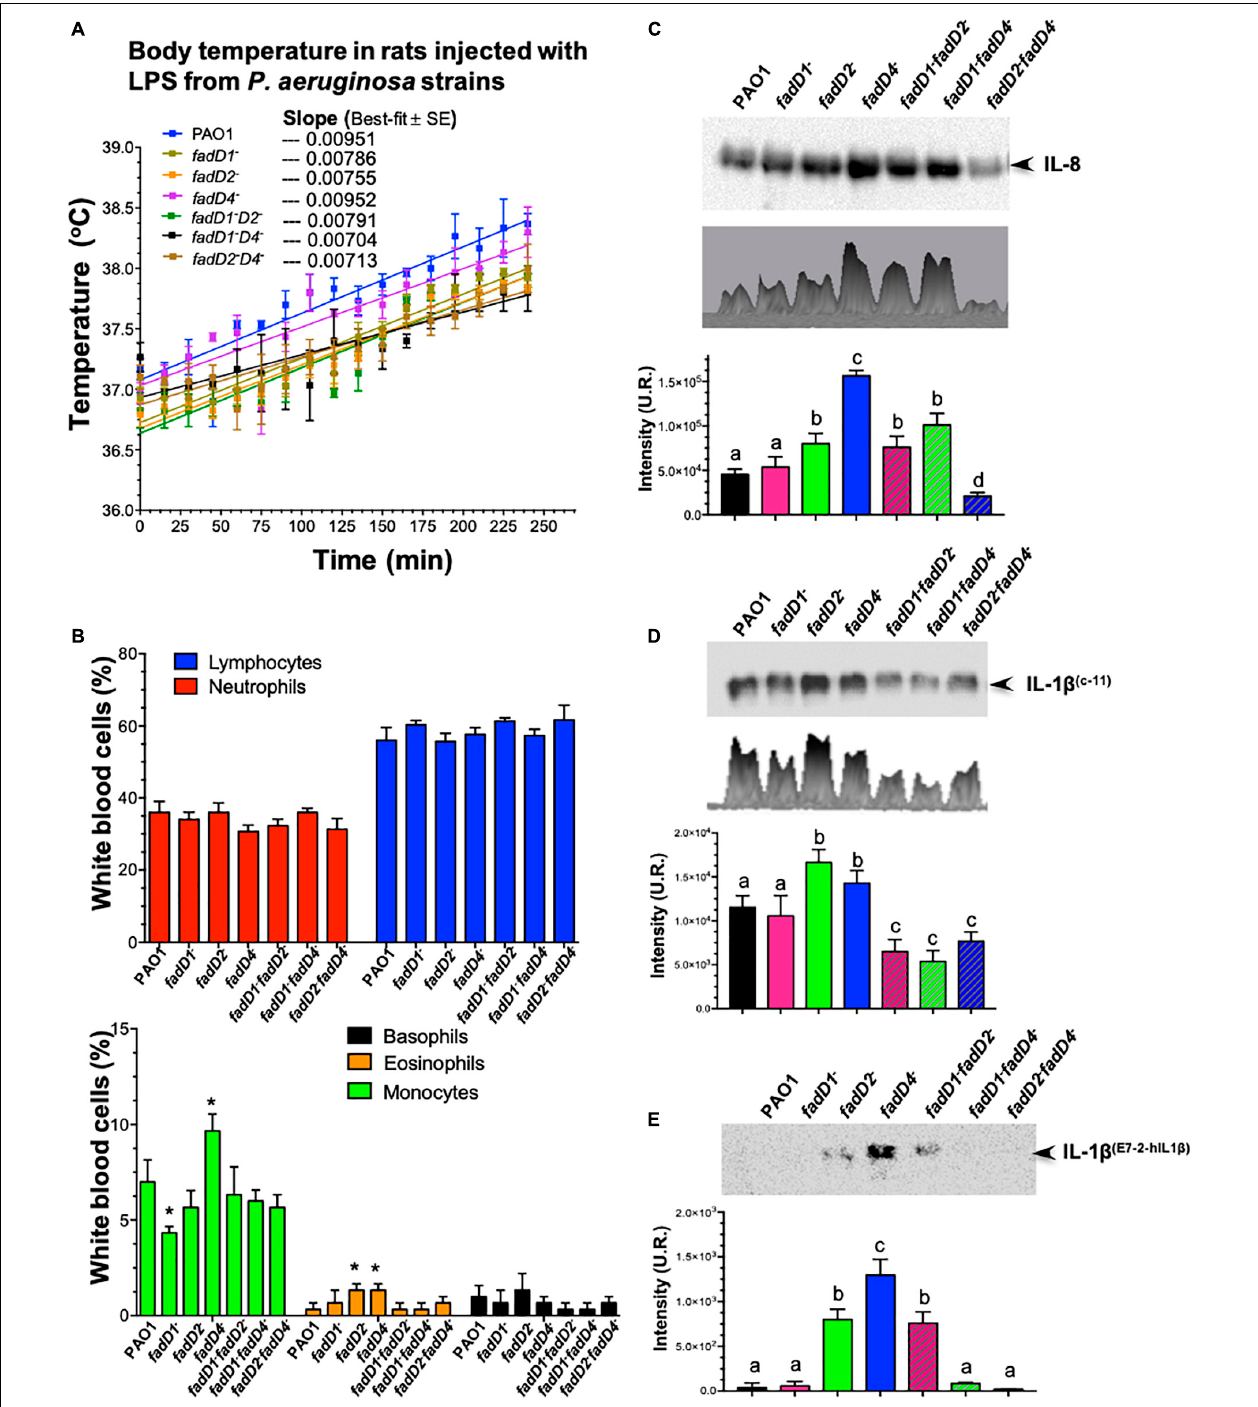
FIGURE 9 | The effect of LPS from fadD mutants of P. aeruginosa PAO1 on body temperature in rats and immunodetection of interleukins. (A) Change in temperature in Wistar rats in response to intraperitoneal injections of LPS isolated from the P. aeruginosa PAO1 strains. A dose of 50 µ g/kg induced fever in all rats after injection ( n = 3). Lineal correlation curves are shown, and values of slopes of best fit are indicated. (B) Determination of proportions of white blood cells in rats treated with LPS samples. (C–E) Immunodetection of interleukins in the serum of rats after LPS treatment: (C) IL-8 using anti-IL-8 antibody (sc376750, Santa Cruz Biotechnology), (D) IL-1 β using anti-IL-1 β (C-11) antibody (sc-52012, Santa Cruz Biotechnology), and (E) IL-1 β using anti-IL-1 β (E7-2-hIL1 β ) antibody (sc-32294, Santa Cruz Biotechnology). Immunodetection of interleukins on western blot membranes was analyzed by densitometry using the Image Lab 6.0.1 software. One-way ANOVA with a Bonferroni post hoc test was used to compare treatments with respect to control. Significant difference ( P < 0.05) vs. control is denoted by lowercase letters or asterisks (*).